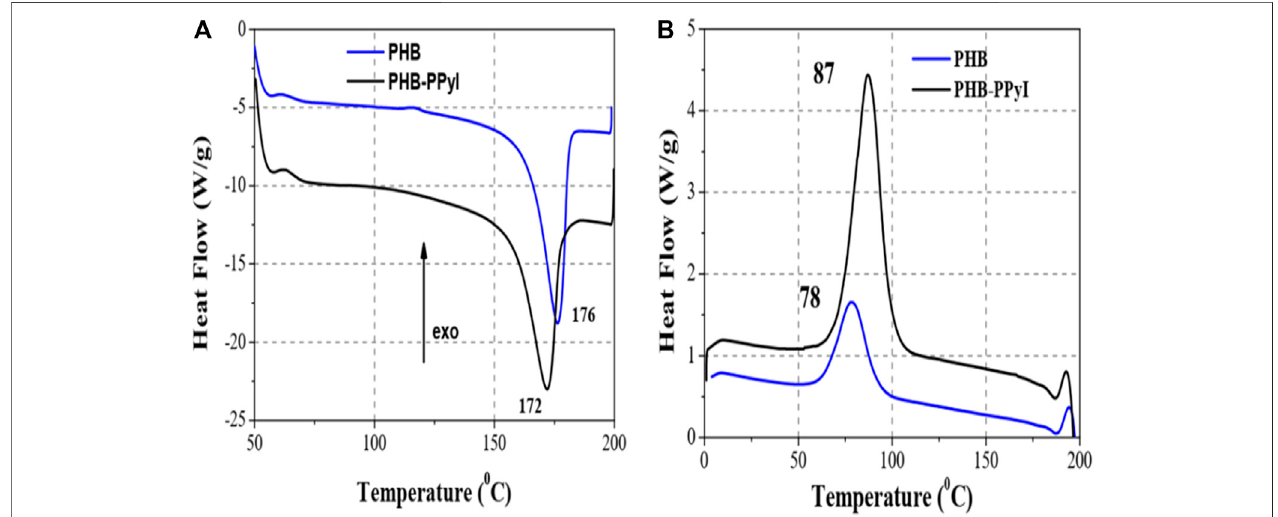
FIGURE 5 | DSC thermograms of PHB and PHB-PPyI scaffolds on (A) heating and (B) cooling.